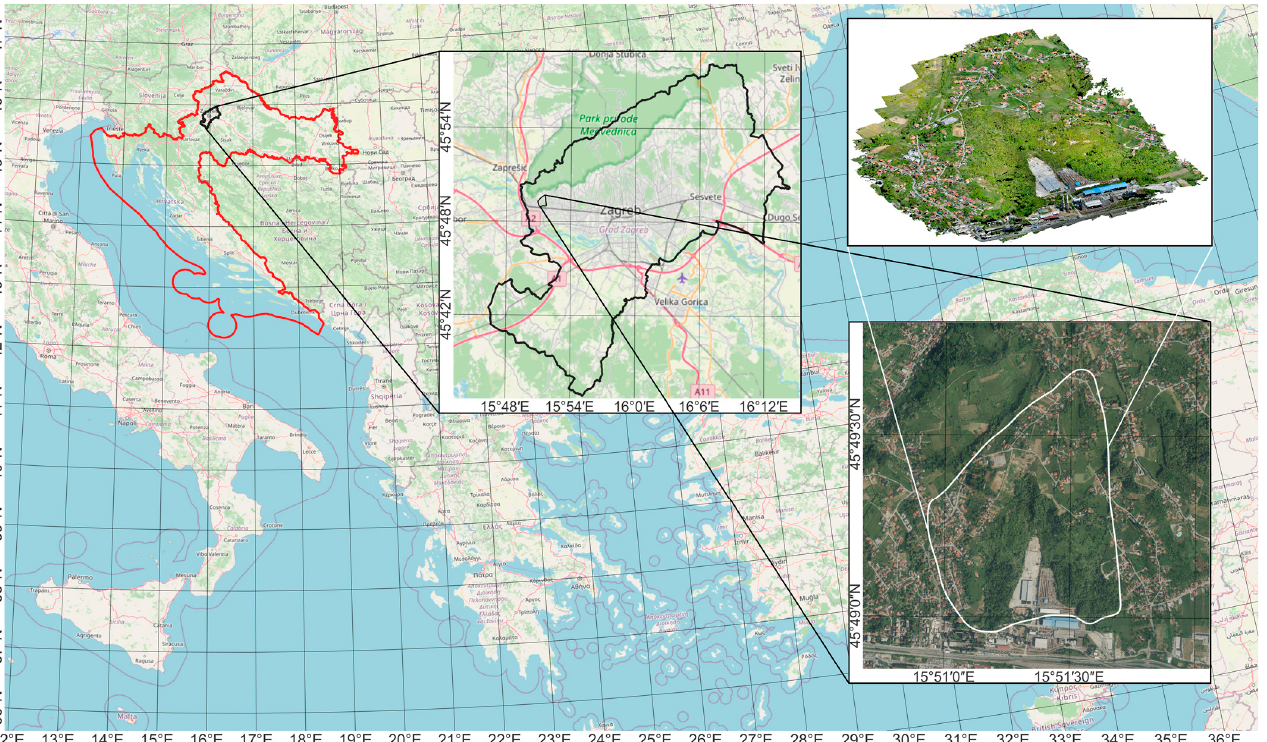
Figure 4. Location of the Kostanjek landslide.